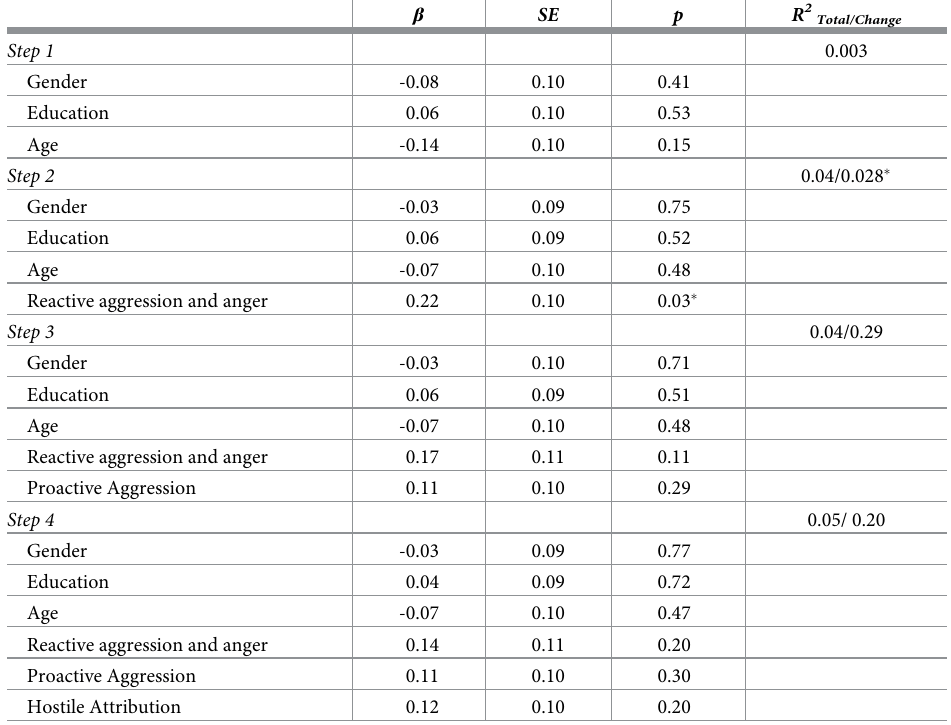
in WM (BS1 , β = 0.22, p = 0.03, model at step 2) and negatively predicted attentional POSITIVE bias away from angry faces whilst holding an angry face in WM (BS1 , β = -0.19, p = NEGATIVE 0.05). Reactive aggression and anger scores did not predict bias towards or away from targets after proactive aggression was added. There were no significant anger or aggression predictors Table 2. Hierarchical multiple linear regression analysis predicting attentional bias toward angry faces whilst holding an angry face in WM (BS1 POSITIVE ).